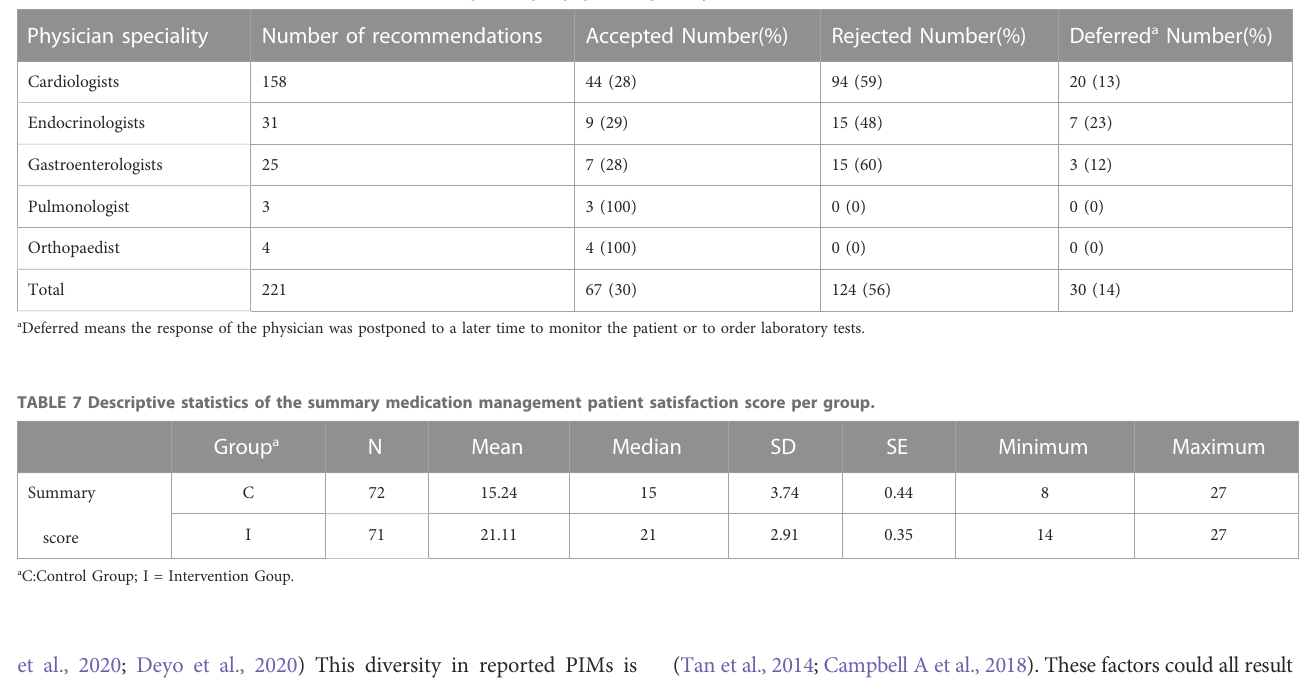
TABLE 6 Number of recommendations and associated responses per physician specialty ( N = 221).